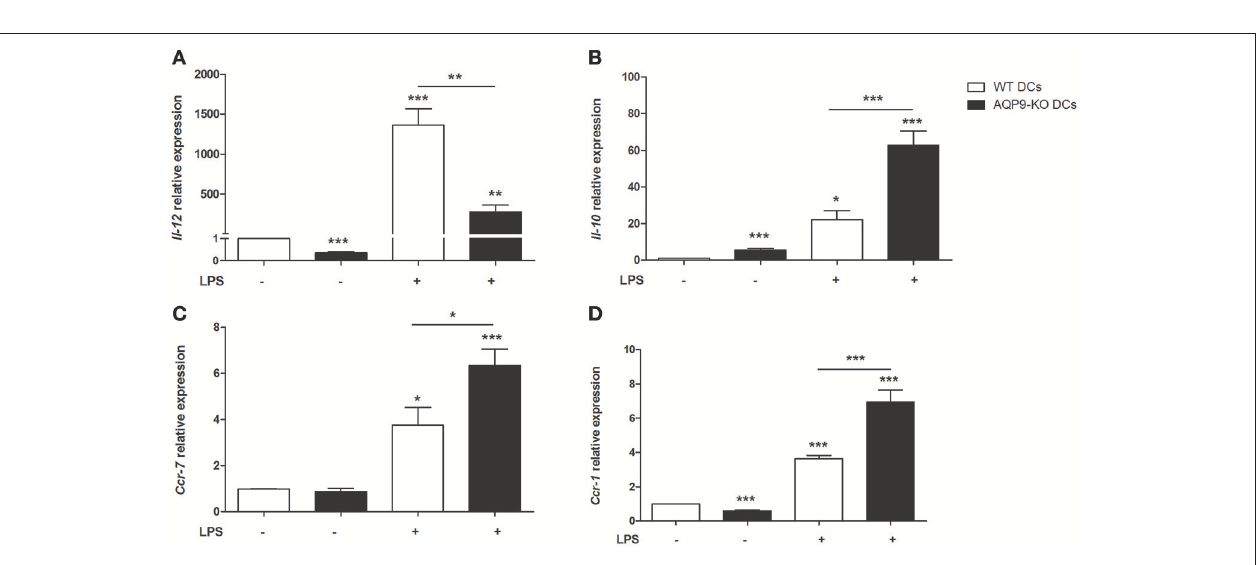
FIGURE 6 | Expression analysis of Aqp9-KO DCs. The expression of Il-12 , Il-10 , Ccr-7, and Ccr-1 was assessed in BMDCs of WT and Aqp9-KO mice (A–D) . Bars represent the mean ± SEM of 3 independent experiments. * P < 0.05, ** P < 0.01, *** P <